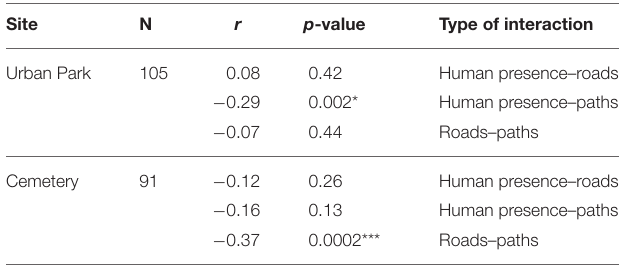
TABLE 4 | Pearson’s correlations and significance tests investigating collinearity between human presence and distances to infrastructural facilities. Site N p